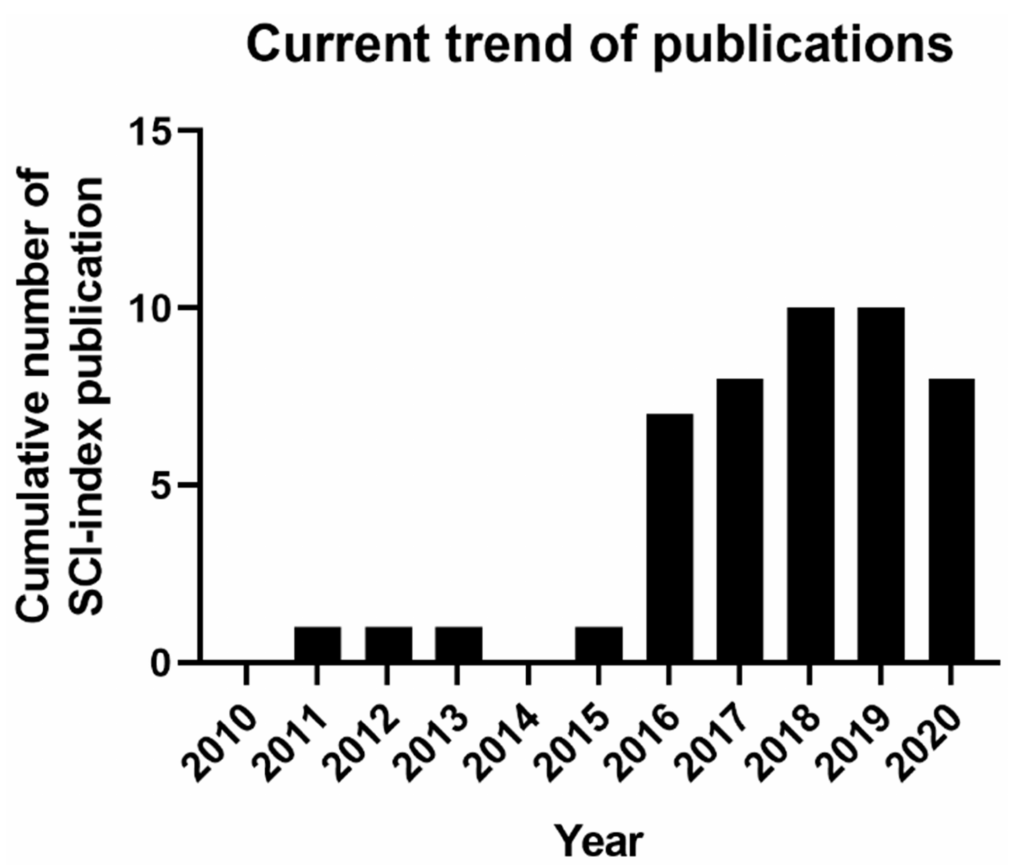
Figure 3. The current trend of SCI-indexed publications on Web of Science for chronic wound healing treatment by using a 3D-bioprinting